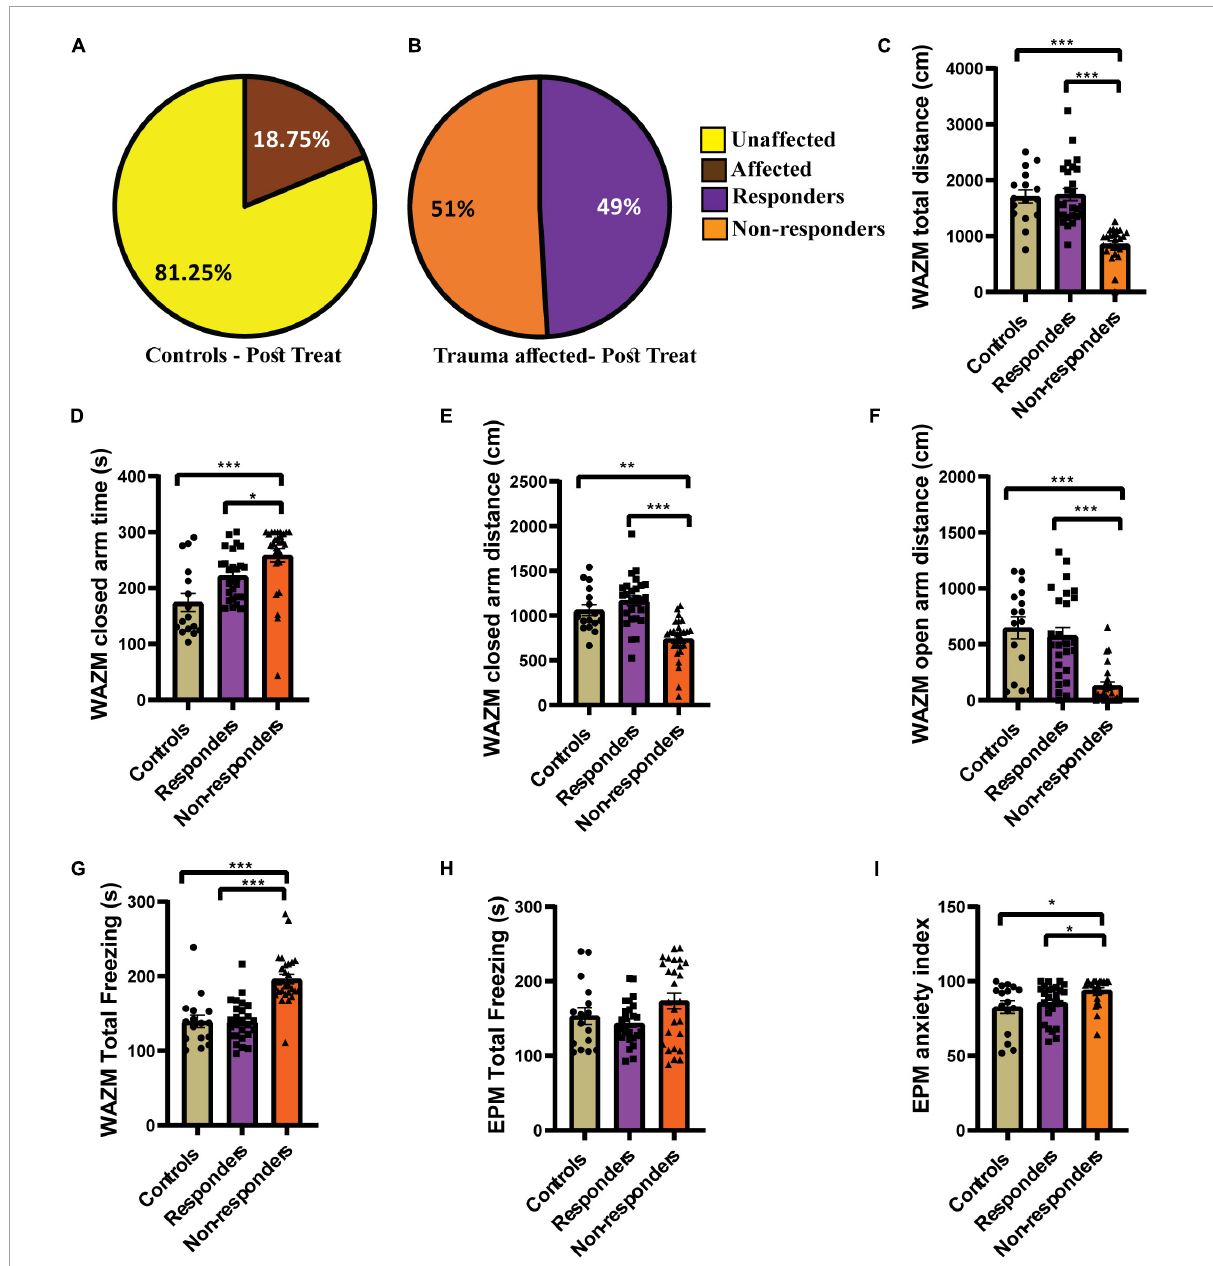
FIGURE4 IBP1 classified JVS+UWT affected animals as treatment responders and non - responders . (A) Percentage of affected and unaffected animals in the control group at the post-fluoxetine time point. (B) Percentage distribution of treatment responders and non - responders in the trauma affected group after fluoxetine treatment. Controls ( n = 16), trauma affected animals administered fluoxetine ( n = 53). (C) Total distance traveled in WAZM by the non - responders was the least while responders and control traveled similar distance [Kruskal–Wallis test (H (3) = 41.51, p < 0.0001); Dunn’s post-hoc comparison p *** < 0.0001]. (D) Time spent in the WAZM closed arms was the highest by the non - responders but responders and controls spent similar time [Kruskal–Wallis test (H (3) = 20.62, p < 0.0001); Dunn’s post-hoc comparison p *** < 0.0001, p * < 0.05)]. (E) Distance traveled in the closed arms was the least by non - responders but responders and controls traversed similar distance [Kruskal–Wallis test (H (3) = 28.11, p < 0.0001); Dunn’s post-hoc comparison p ** < 0.01, p *** < 0.0001]. (F) Distance traveled in the open arm of the WAZM was least by the non - responders while responders and controls covered similar distances [Kruskal–Wallis test (H (3) = 27.21, p < 0.0001); Dunn’s post-hoc comparison p *** < 0.00001]. (G) Total time spent freezing in the WAZM was highest amongst the non - responders but responders and controls spent similar time freezing [Kruskal–Wallis test (H (3) = 34.13, p < 0.0001); Dunn’s post-hoc comparison p *** < 0.00001]. (H) Time spent freezing in the EPM was not statistically different between controls , responders and non - responders [Kruskal–Wallis test (H (3) = 3.573, p = ns]. (I) Anxiety index in the EPM was highest in the non - responders while responders and controls had similar anxiety index [Kruskal–Wallis test (H (3) = 11.85, p < 0.01); Dunn’s post-hoc comparison p * < 0.05]. All data represented as mean ± SEM. Controls ( n = 16), treatment responders ( n = 26), treatment non-responders ( n =